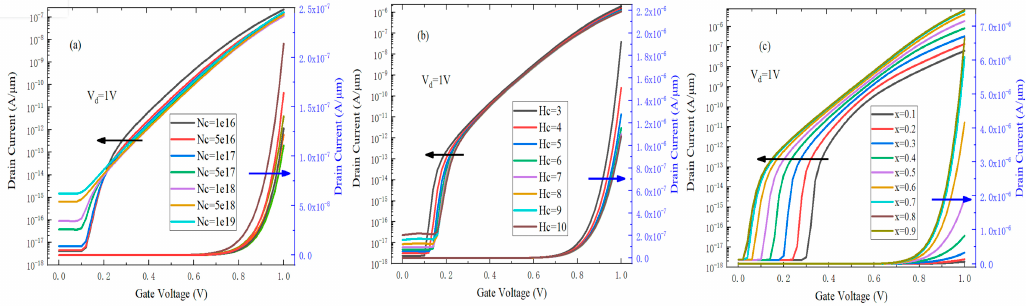
Figure 5. The effects of ( a ) the channel doping concentration; ( b ) the channel height; and ( c ) the Ge content in Si 1-x Ge x material on the transfer characteristics of the H-JLTFET.